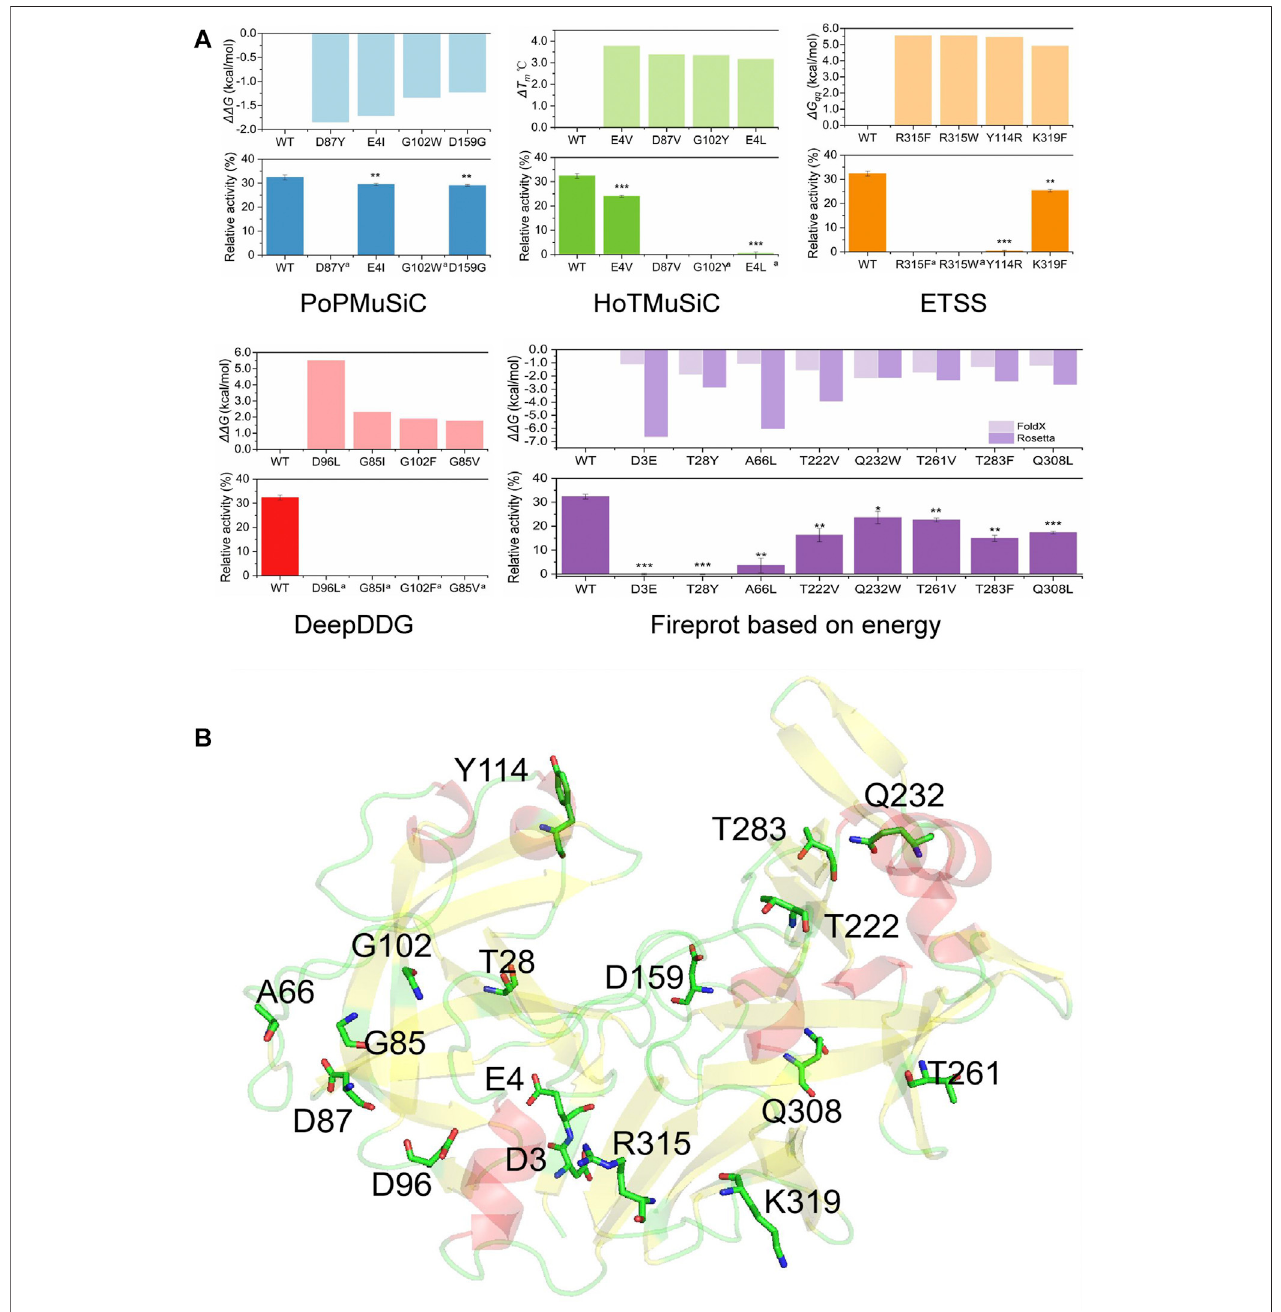
FIGURE 2 | Thermostability results and analyses of positions of the set of mutations predicted using various energy-based software programs. (A) Software programs ’ parameters and relativeactivities ofsingle-pointmutations after incubation at 65 ° Cfor 3 min. Dataare mean ± s.e.m. *** p < 0.001,** p < 0.01, * p < 0.05. Data are from three independent experiments. (B) Positions of mutations on the pepsin structure. a indicates that the activity of the original crude enzyme is too low to be measured.